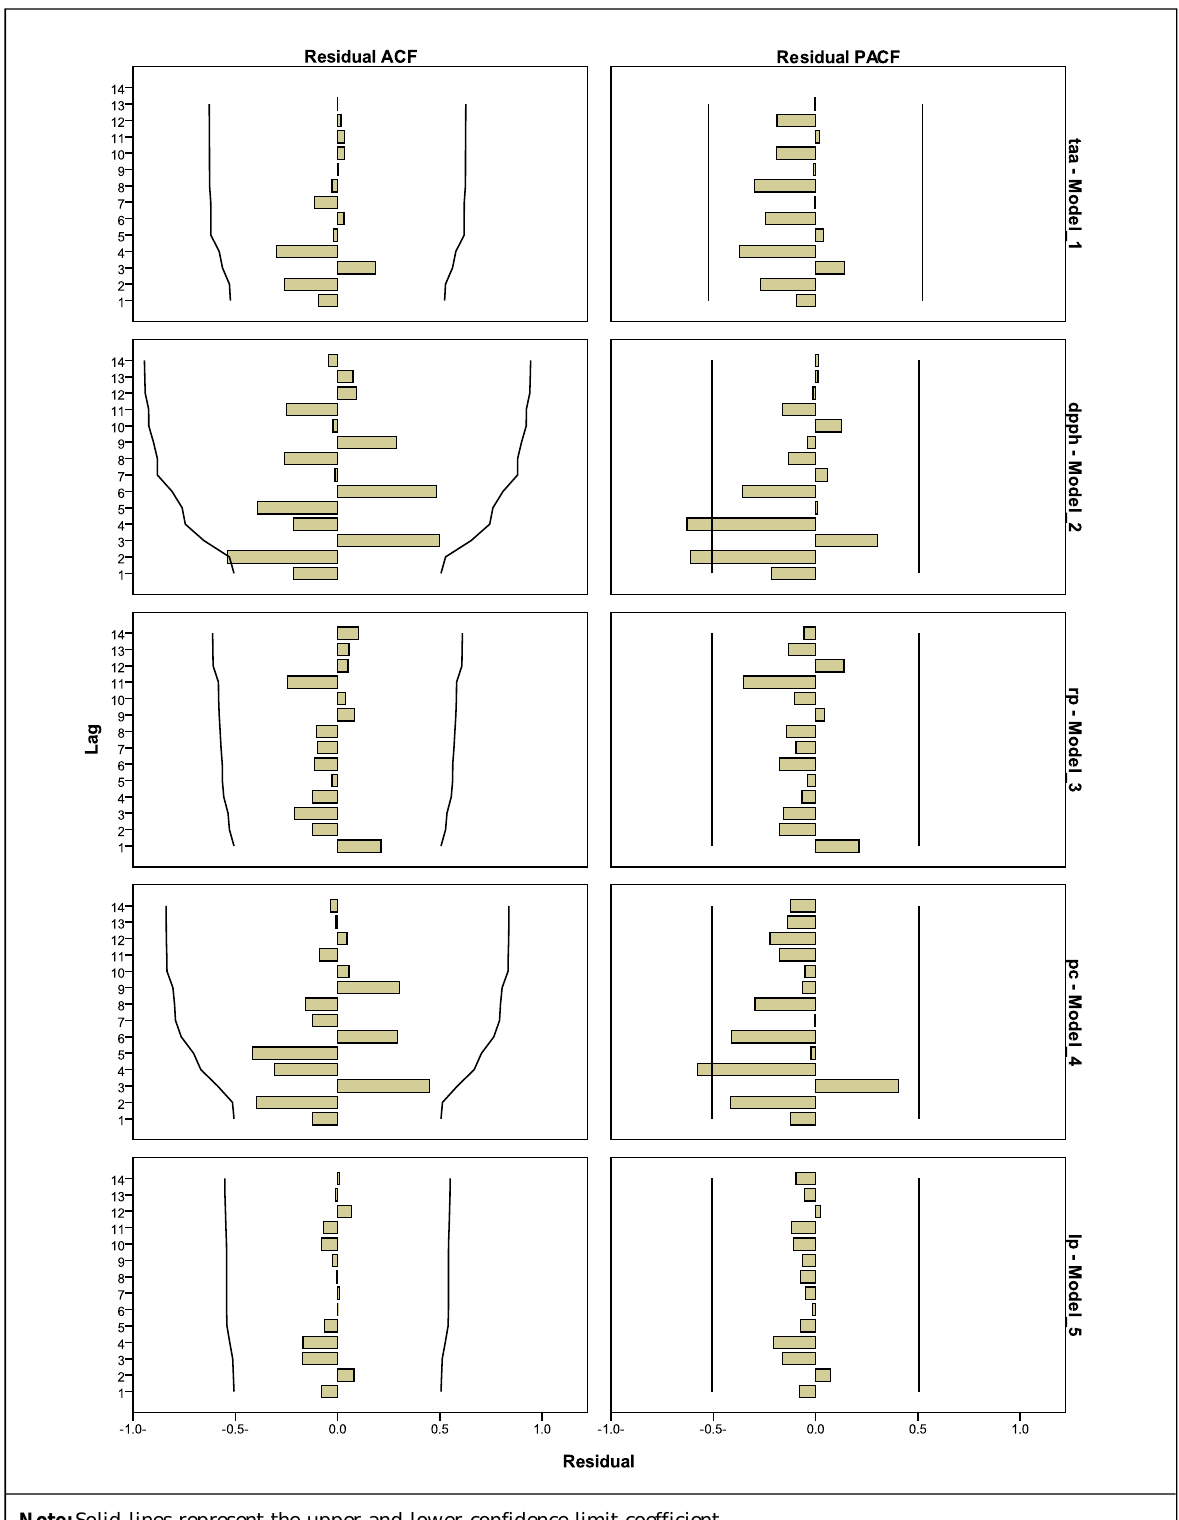
Note: Solid lines represent the upper and lower confidence limit Figure 4: The autocorrelation function (ACF), and partial autocorrelation function plot (PACF) of the residual series between the forecasted series and the real (differential) series of time course post injection of vitamin B12 (0, 6, 12, 18, and 24 h) on the tested oxidative stress parameters total antioxidant capacity (tta), reducing power ability (rp), 2,2 diphenyl-1-picylhydrazyl (dpph), protein carbonyls amount (pc), and lipid peroxides levels (lp) of adult of Sitophilus oryzae .